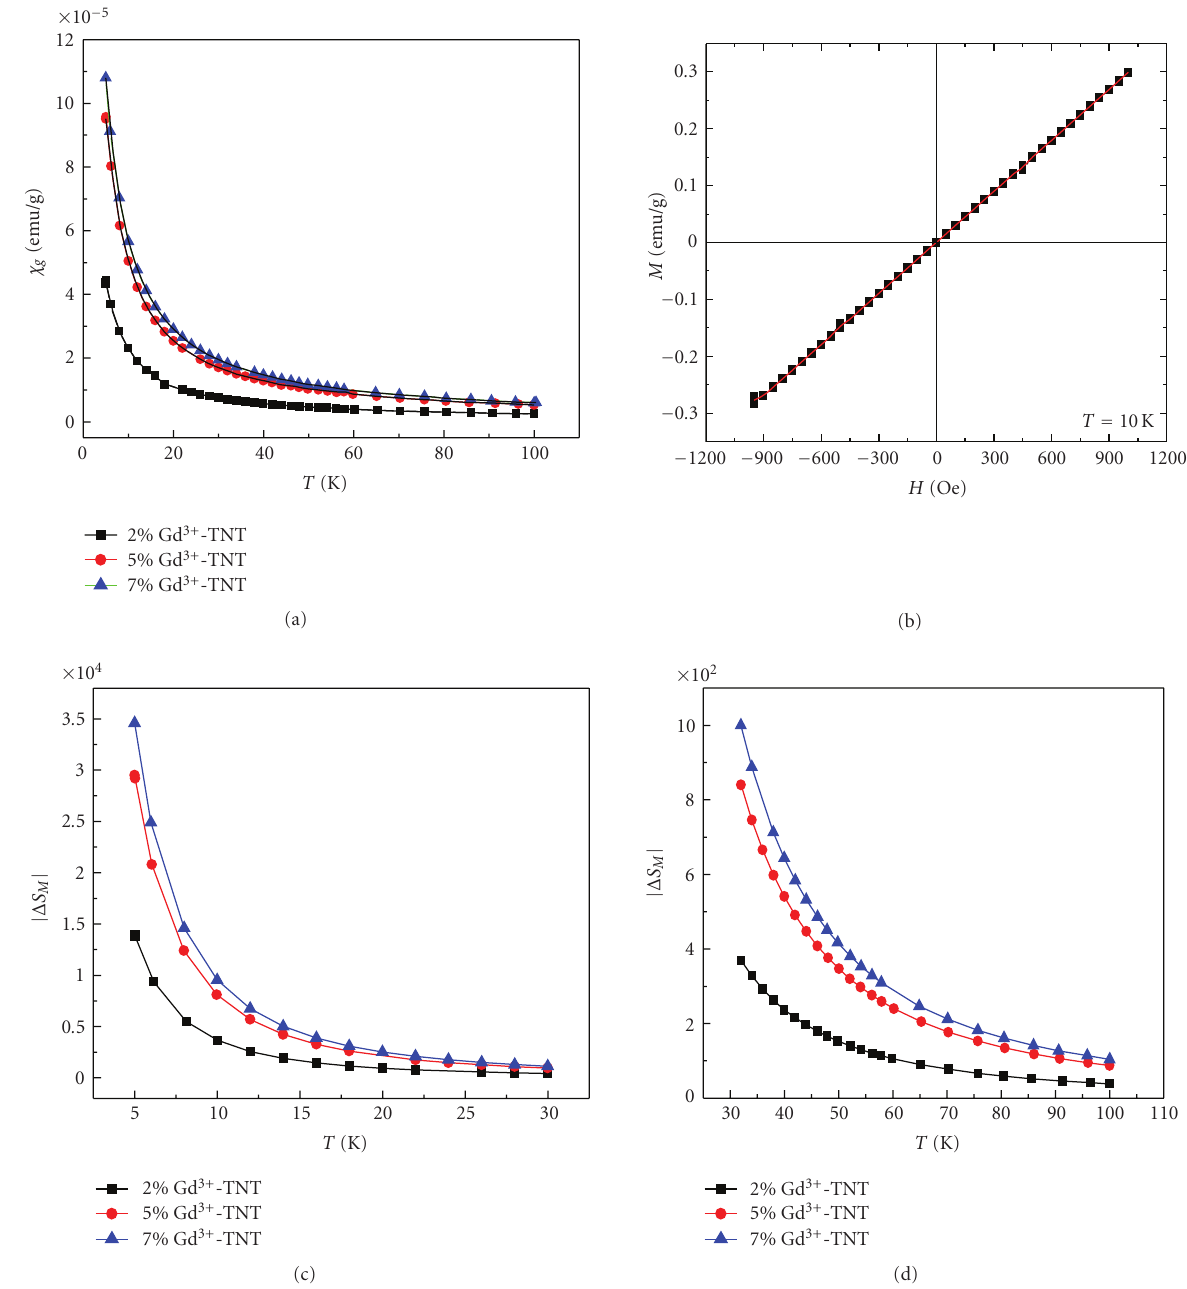
Figure 6: (a) dc magnetic susceptibility versus temperature for x Gd 3+ -(100- x ) TNT, where ( x = 2, 5, 7); (b) The magnetization versus the applied field curves ( M versus H ) of 2% Gd 3+ -98 TNT at 10 K (as a representative example); as well as (c) and (d) Temperature dependence of the entropy change for di ff erent mole percent of Gd 3+ -TNT under an external magnetic field equal to 400